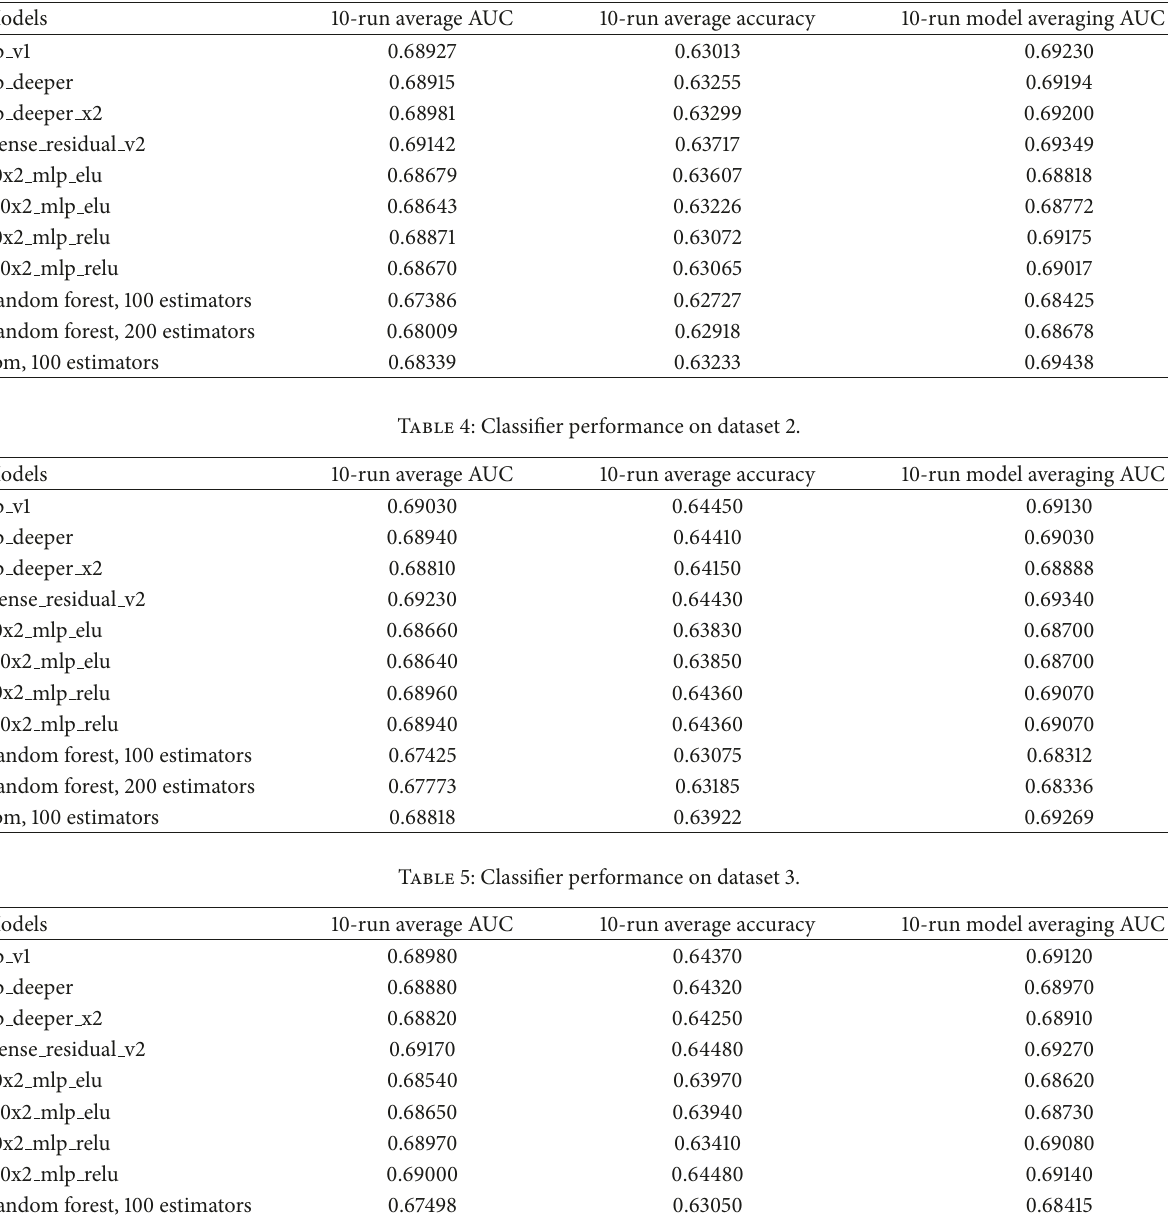
Table 3: Classifier performance on dataset 1.